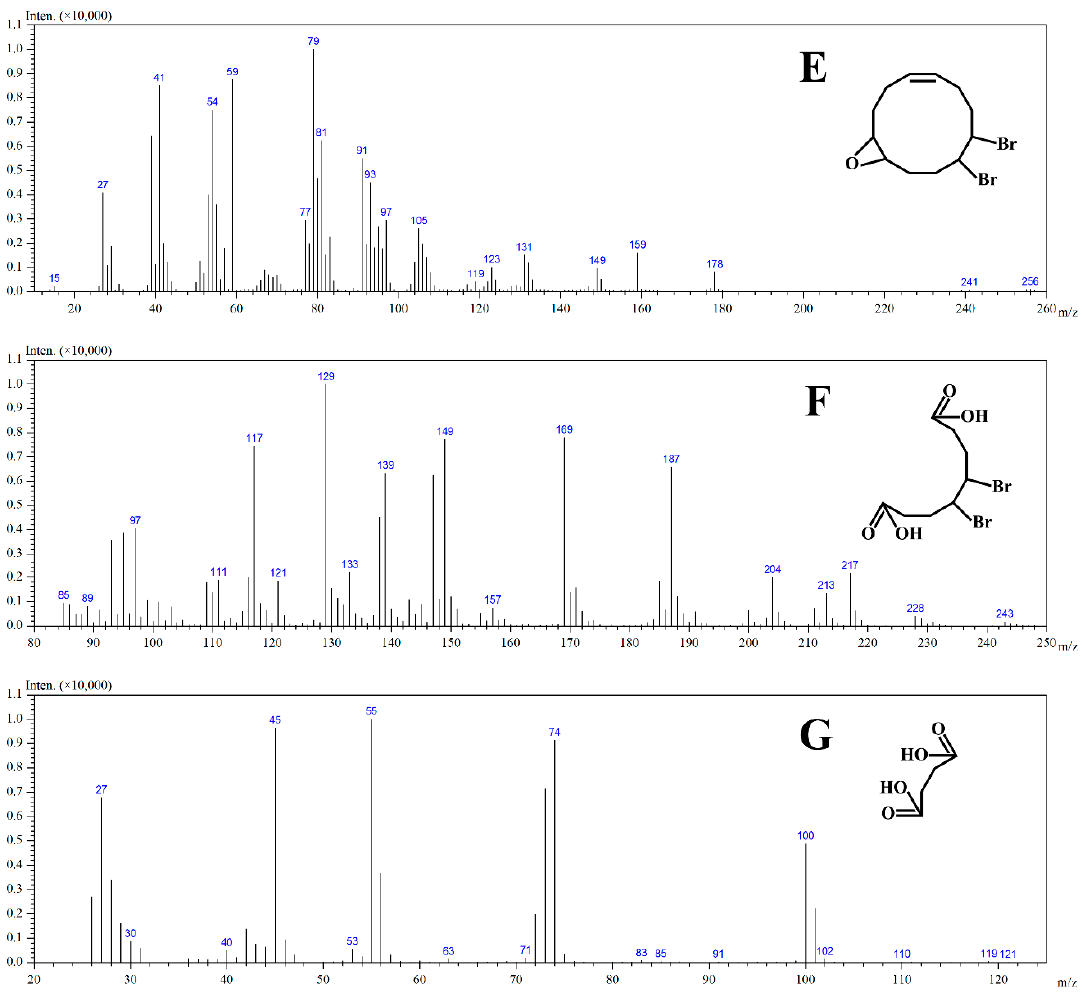
Figure 6. The mass spectrum of the intermediates in the UV/TiO 2 /KPS system at 90 min (( A ) Tetrabromocyclododecene; ( B ) Dibromocyclododecadiene; ( C ) 1,5,9-Cyclododecatriene; ( D ) 1,2-Epoxy-5,9-cyclododecadiene; ( E ) Dibromo-epoxy-cyclododecene; ( F ) 4,5-dibromooctanedioic acid; ( G ) succinic